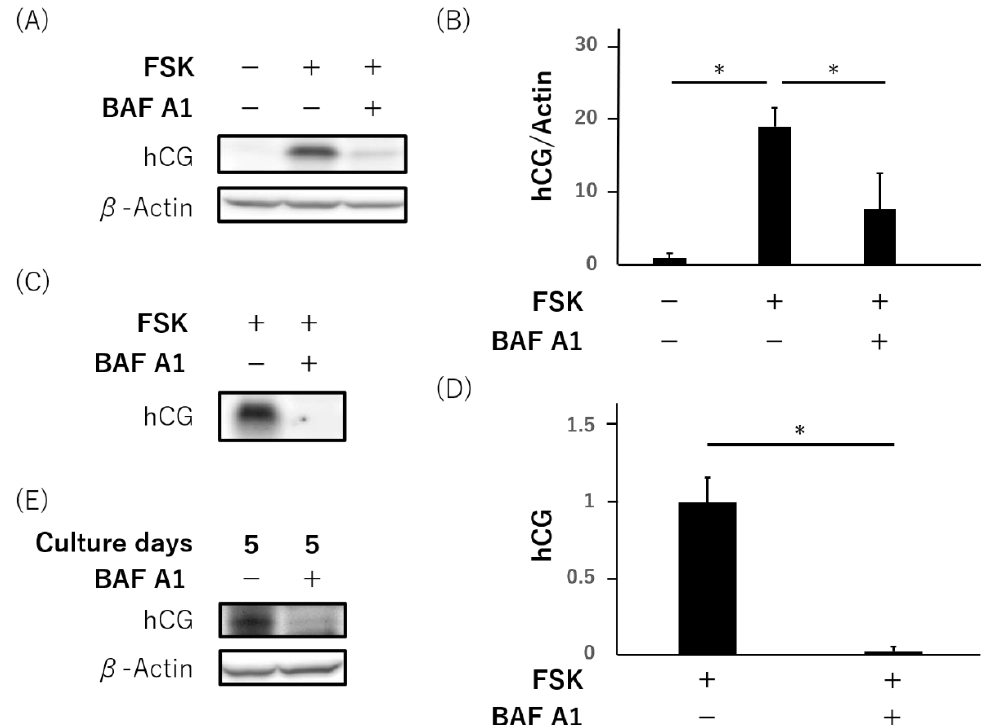
Figure 4. Bafilomycin A1 (BAF A1) inhibited hCG production and secretion during syncytialization. BeWo cells were treated with Forskolin (FSK) 25 µ M and BAF A1 20 nM simultaneously. The hCG in the cell lysate ( A ) and in the culture media ( C ) was evaluated. The graphs show the intracellular ( B ) and secreted ( D ) hCG. Bands were quantified using Image J. To evaluate secreted hCG and evaluate changes in hCG in supernatant, Ponceau S staining was used to confirm equal protein loading across the lanes. hCG production in primary human trophoblasts (PHT) was evaluated in the presence of BAF A1 ( E ). The cells were cultured in the media without BAF A1 for 72 h, and then cultured in the media with 20 nM of BAF A1 for the following 48 h. The graphs were obtained from the three independent results. A significance test was performed: * p < 0.05.